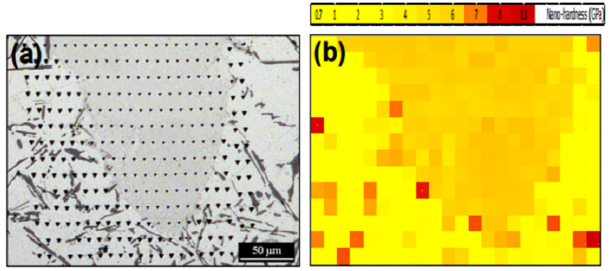
Figure 62. ( a ) SEM image of AlSi10Mg SLM sample showing an array of nanoindents across the melt